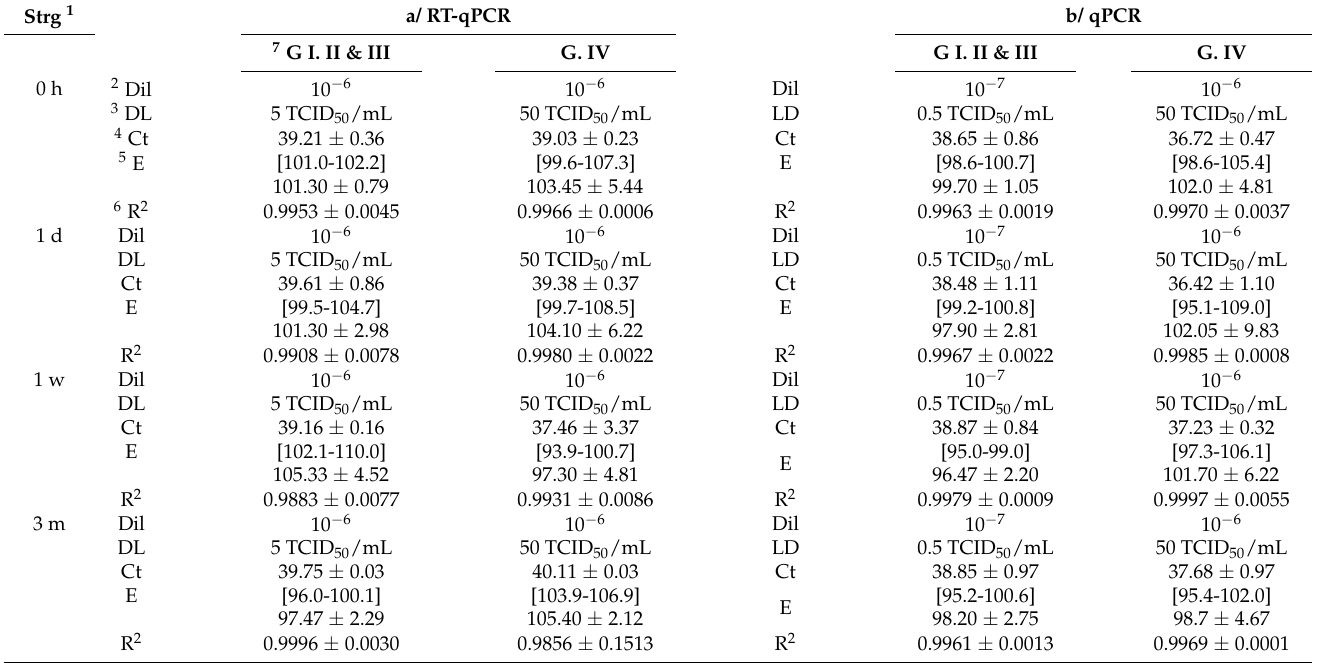
Table 1. Reliability of the macroarray: Summary of